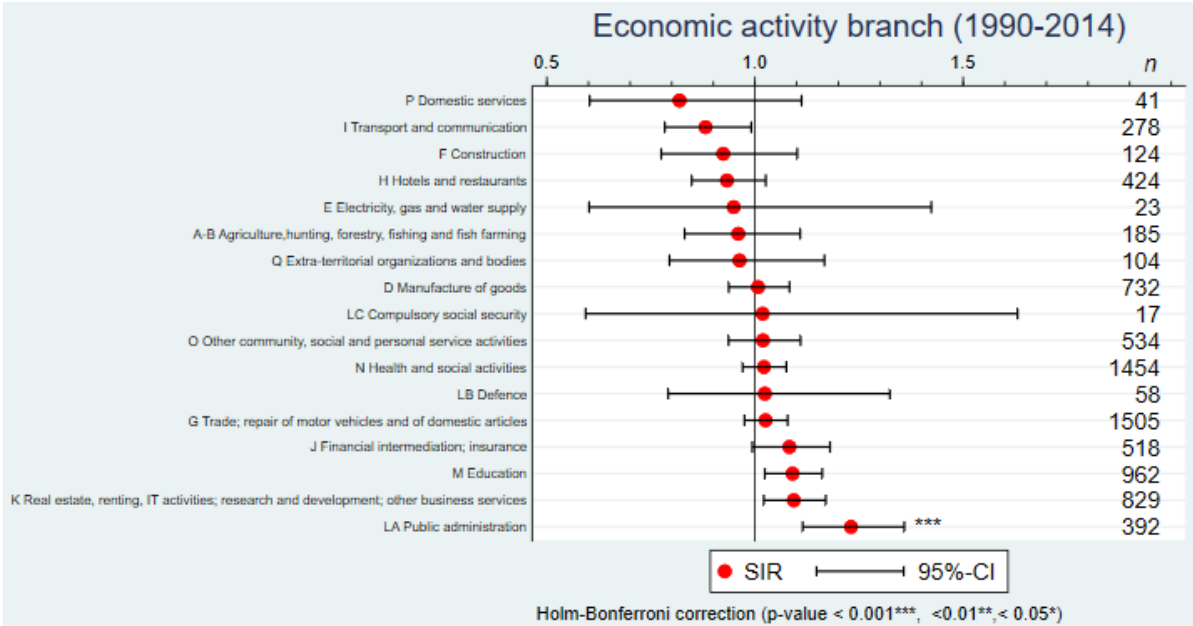
Figure 2. Standardized incidence ratio (SIR) of breast cancer by economic activity branch (17 main NOGA-95 categories) in western Switzerland, 1990–2014. Table 2. Relative risk (RR) with confidence interval (95%CI) of breast cancer by occupational, socio- professional, economic activity and skill level category, among females aged 18–85 years in Swiss cantons of Neuchâtel, Geneva, Vaud and Wallis, 1990–2014.